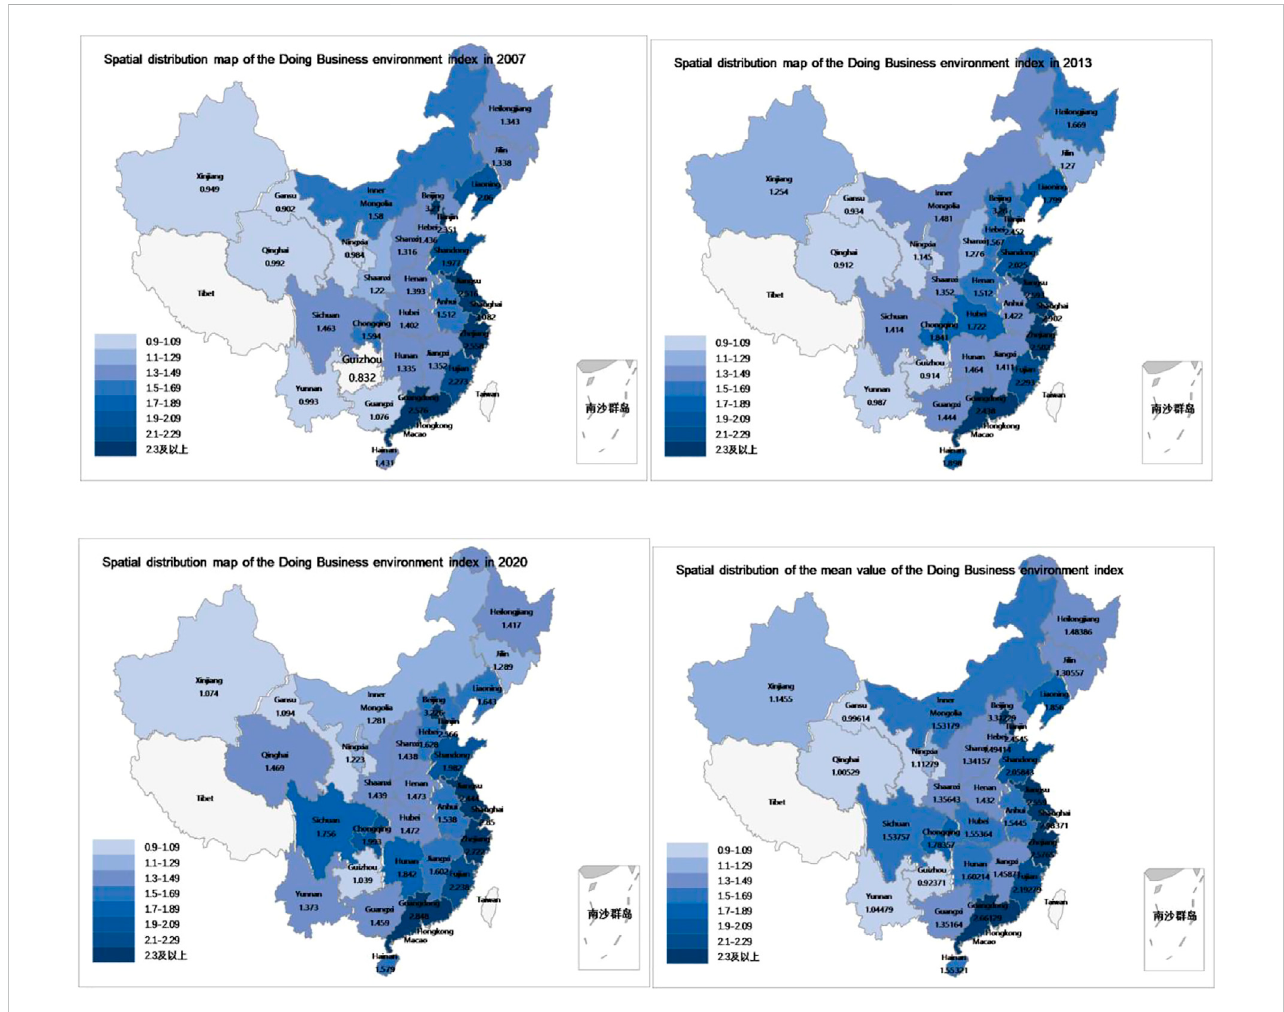
FIGURE 5 The spatial and temporal distribution map of China ’ s DB